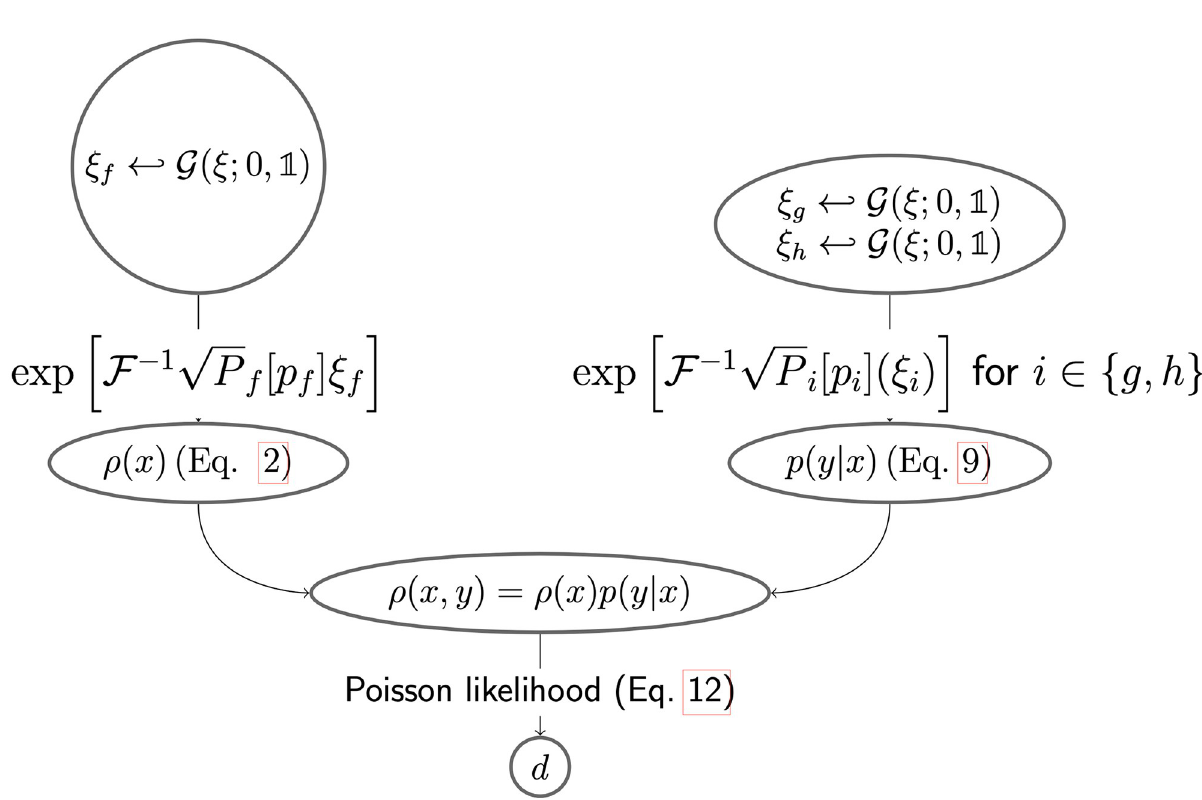
Fig 2. Graph structure of the causal model of age x and viral load y. F denotes the Fourier transform operator. Starting from the top, standard- normally distributed excitations ξ are drawn from the latent priors for f , g , and h . They are then transformed into the non-parametric signal ρ ( x , y ) (Eq 9) by taking the inverse Fourier transform of the Mate´rn kernel parametrization described in Eq 5. Finally, the signal ρ ( x , y ) is compared to the data d through a Poissonian likelihood (Eq